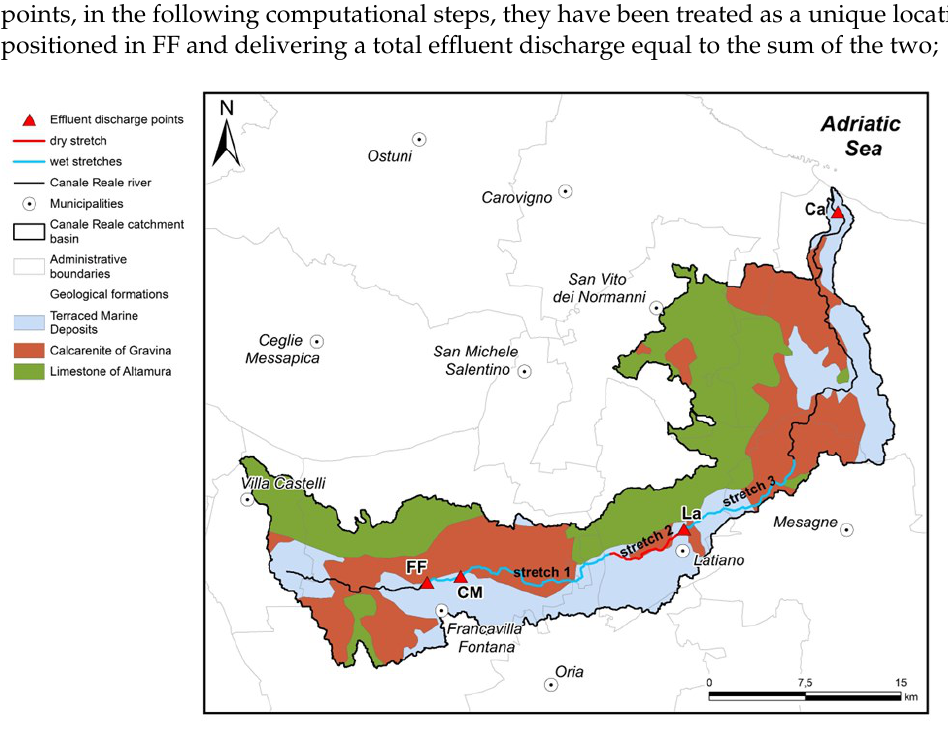
Figure 5. Distribution of wet and dry stretches along the Canale Reale River after the visual